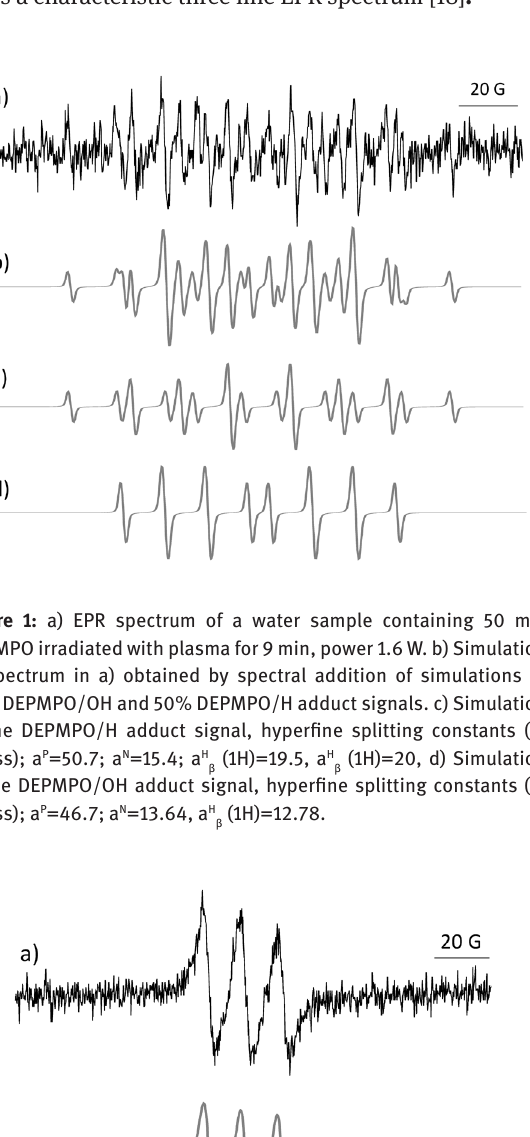
Figure 2: a) Experimental EPR spectrum of the Fe(NO)(DTCS) obtained after plasma irradiation of a water sample containing Fe(DTCS) for 9 min, power 1.6 W. b) Simulated EPR spectrum of Fe(NO) 2 (DTCS) , nitrogen hyperfine splitting constant (in Gauss) a N 2